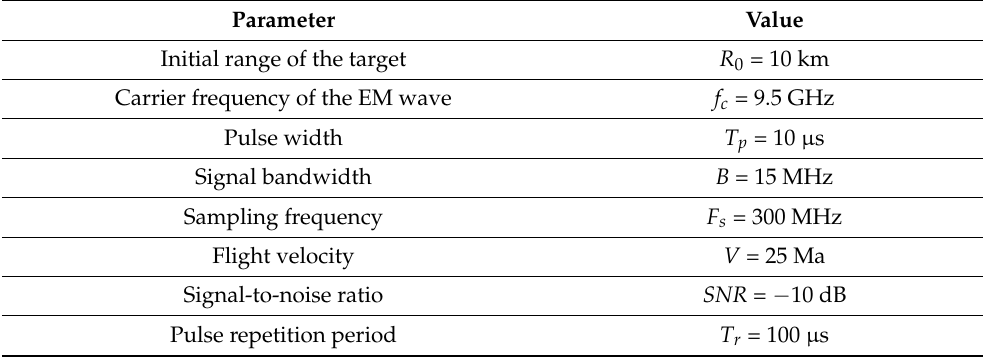
Table 2. Simulation